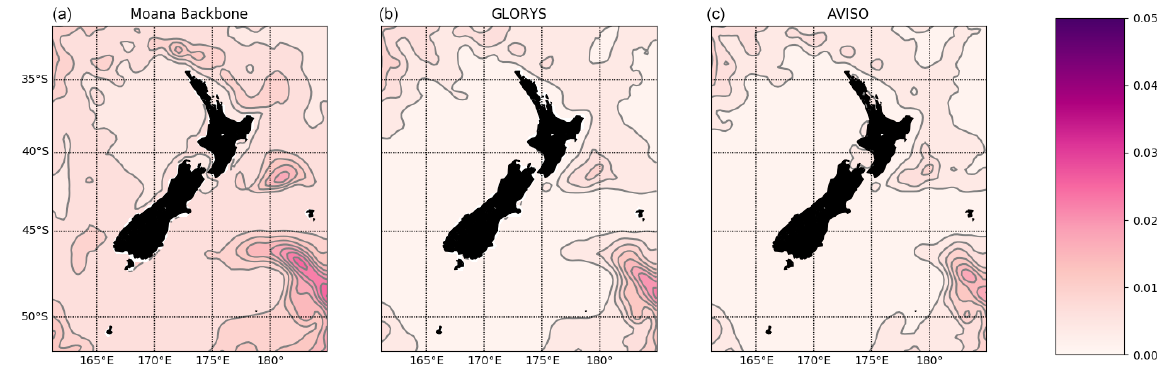
Figure 3. Variance of the SSH (m 2 ) from the free-sunning Moana Ocean Hindcast (a) , the data-assimilating GLORYS (b) simulations and the AVISO product (c) . Although the same general distribution is observed, the Moana Ocean Hindcast presents stronger variability due to its higher spatial resolution. Contours are provided at 0.01m 2 intervals.